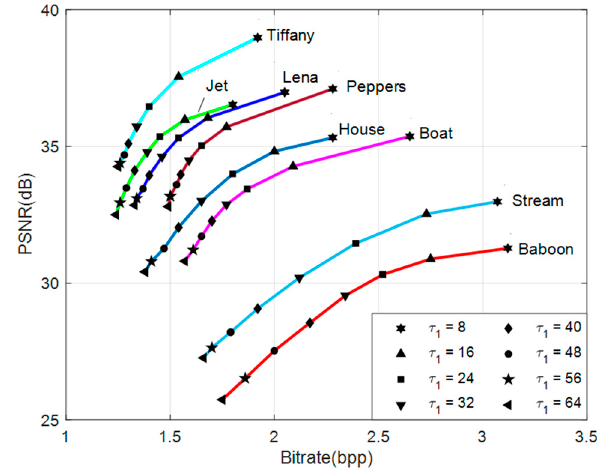
Figure 7. Bitrate – PSNR curves of each of the eight test images. Figure 7. Bitrate–PSNR curves of each of the eight test